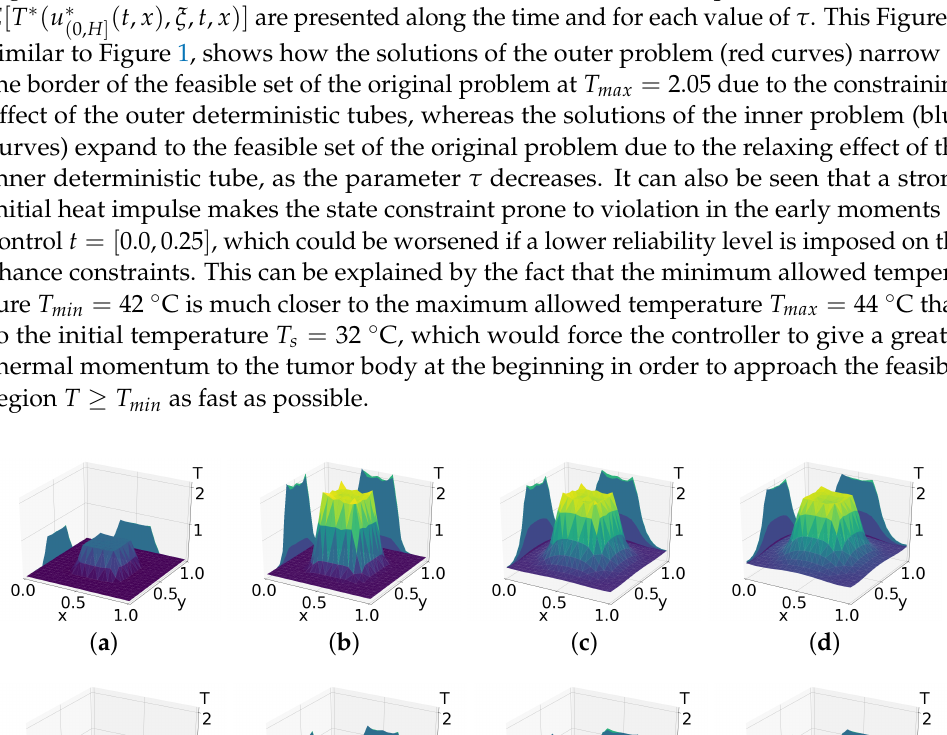
Figure 5. Mean temperature realizations E [ T ∗ ( u ∗ τ = 0.1; ( a ) OA , t = 0.025; ( b ) OA , t = 0.2; ( c ) OA , t = 1.0; ( d ) OA , t = 2.0; ( e ) IA , t = 0.025; ( f ) IA , t = 0.2; ( g ) IA , t = 1.0; ( h ) IA , t = 2.0.